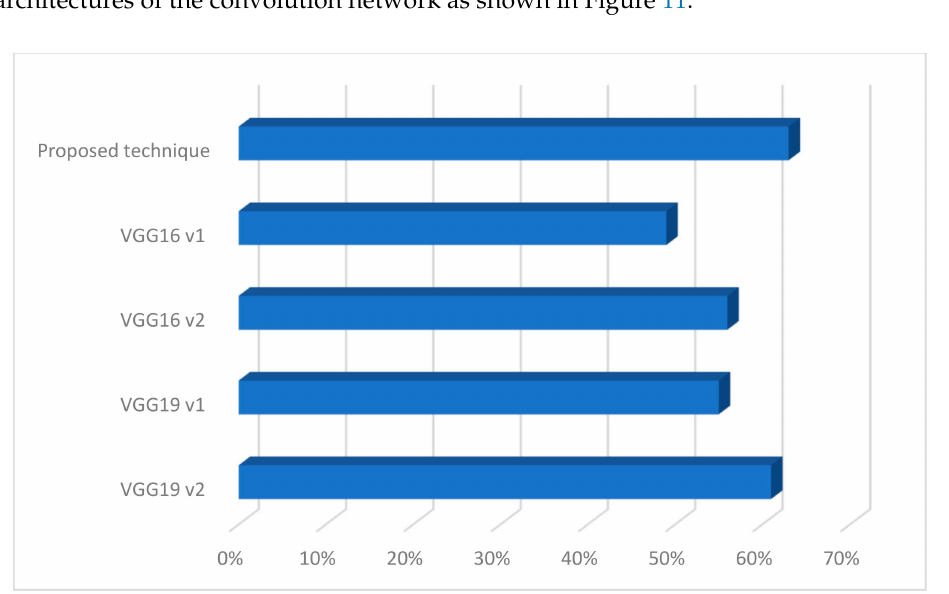
Figure 11. Comparison of di ff erent convolutional neural networks on a selected